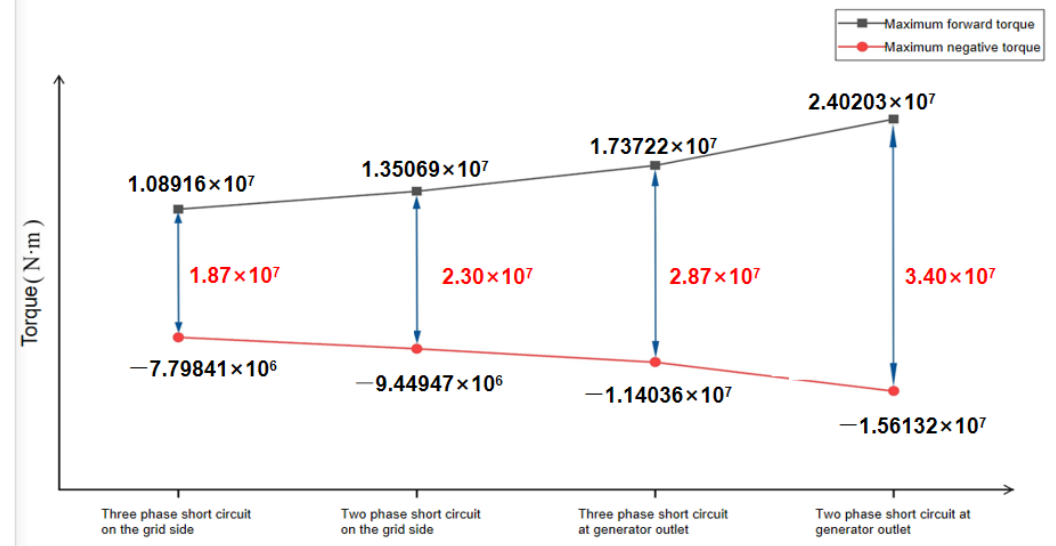
Figure 10. Maximum alternating electromagnetic impulse torque under different short-circfaults.